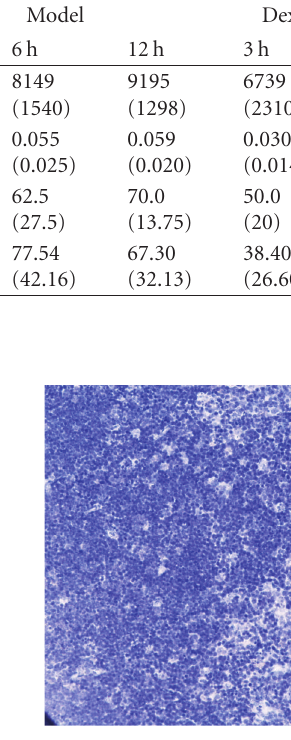
Figure 1: Treated group: 12 hours; NF- κ B ×